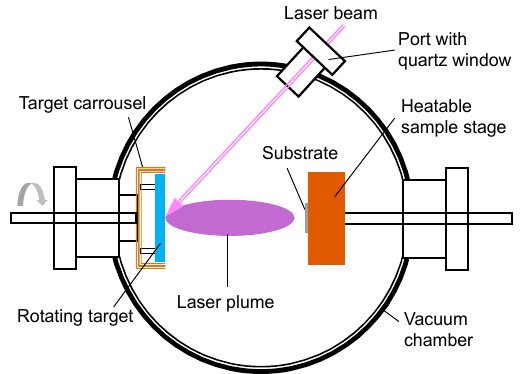
Figure 8. Schematic representation of the main components in a standard pulsed laser deposition (PLD) process.